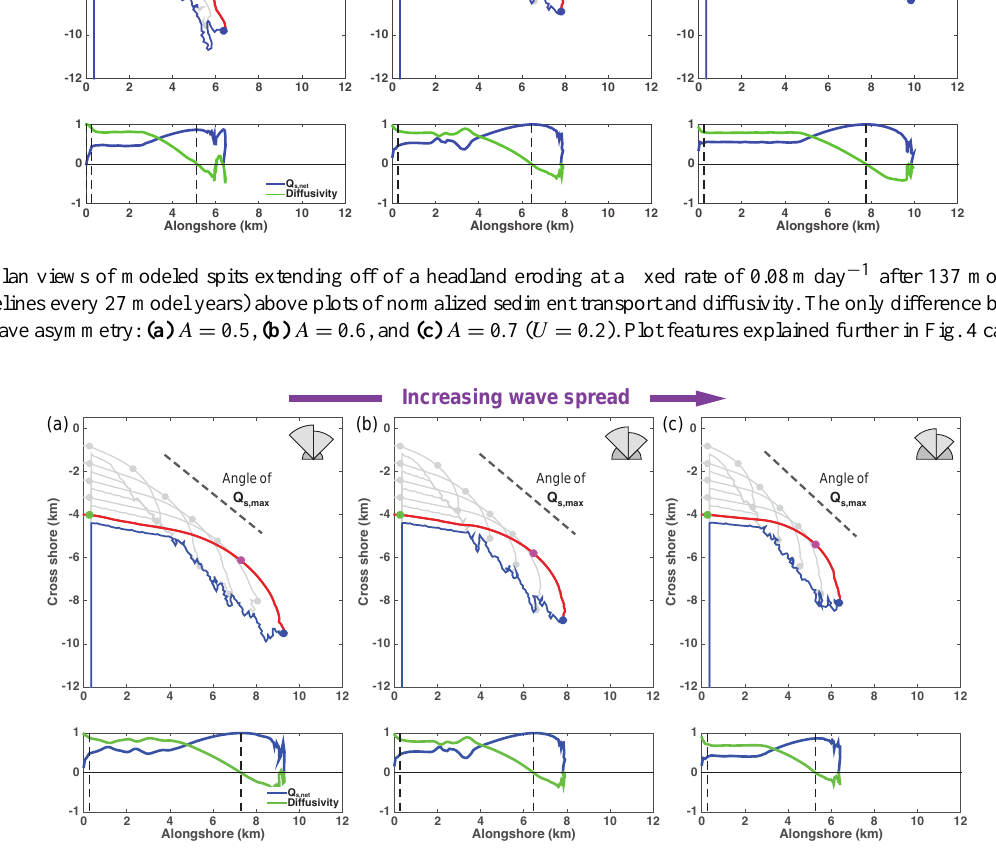
Figure 11. Plan views of modeled spits extending off of a headland eroding at a fixed rate of 0.08mday − 1 after 137 model years. The only difference between simulations is the wave spread: (a) U = 0 . 1, (b) U = 0 . 2, and (c) U = 0 . 3 ( A = 0 . 6). Plot features explained further